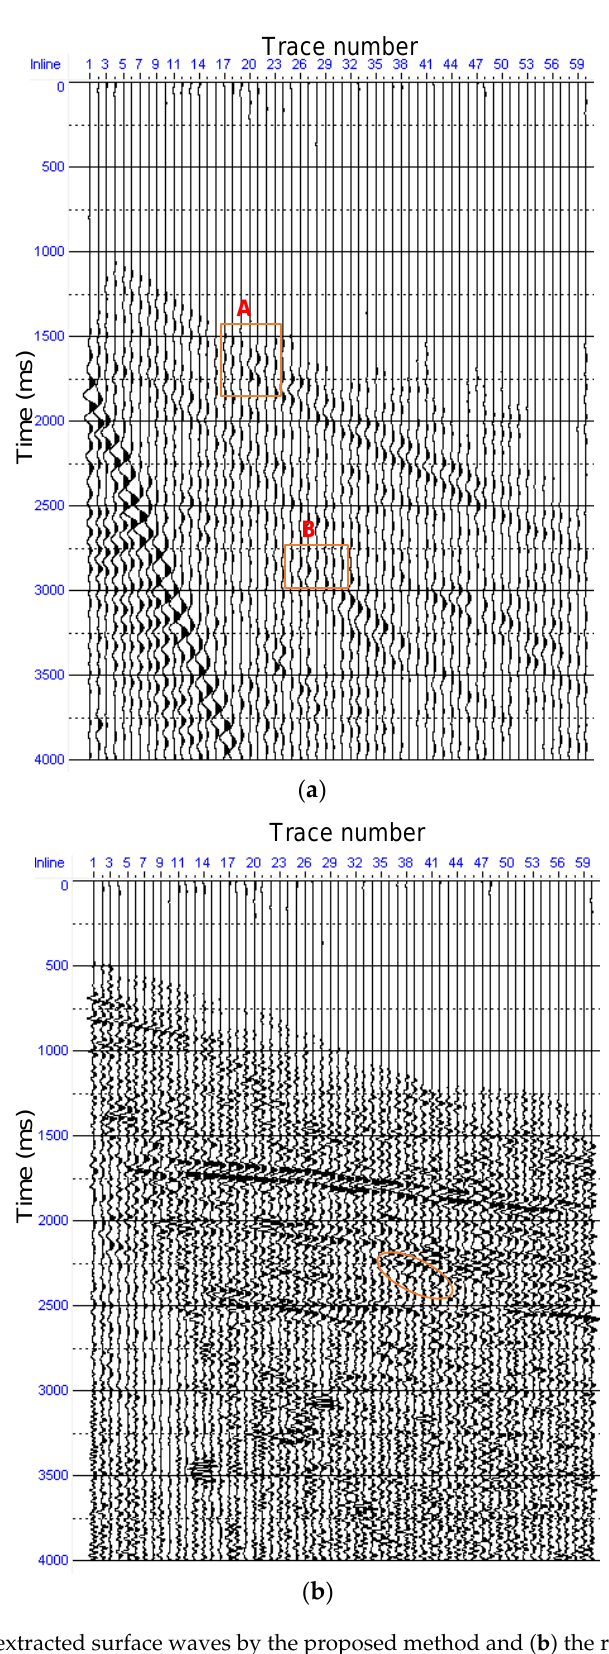
Figure 11. ( a ) The extracted surface waves by the proposed method and ( b ) the rest of the field data.